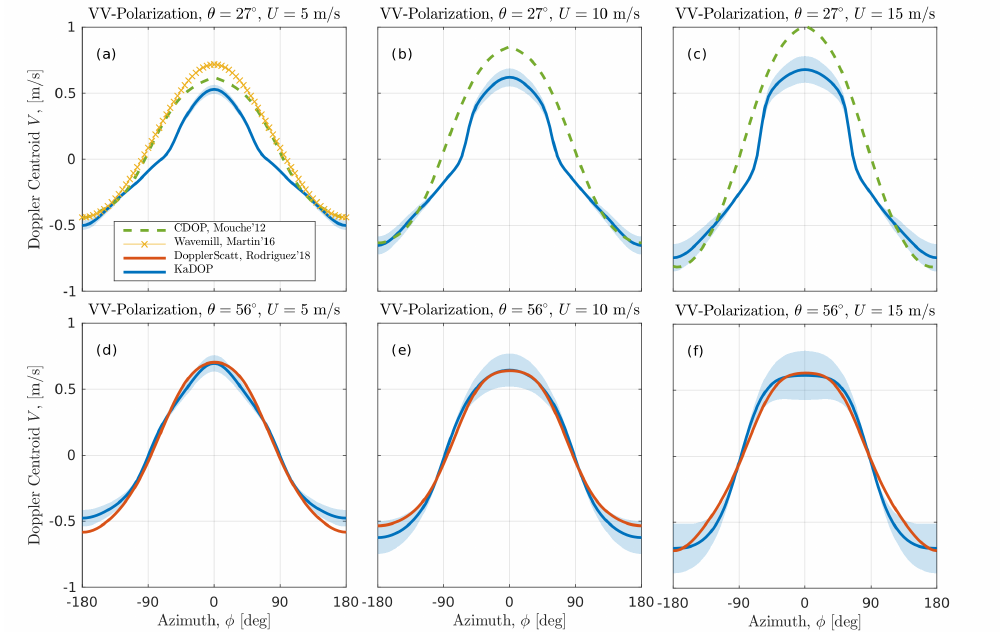
Figure 9. Doppler centroid versus radar-to-wind(wave) azimuth for various wind speeds at VV-polarization, left to right: U = 5,10,15 m/s. ( top row ) θ = 27 ◦ , ( bottom row ) θ = 56 ◦ . Confidence interval corresponds to the wind drift varied from 0 to 3% U